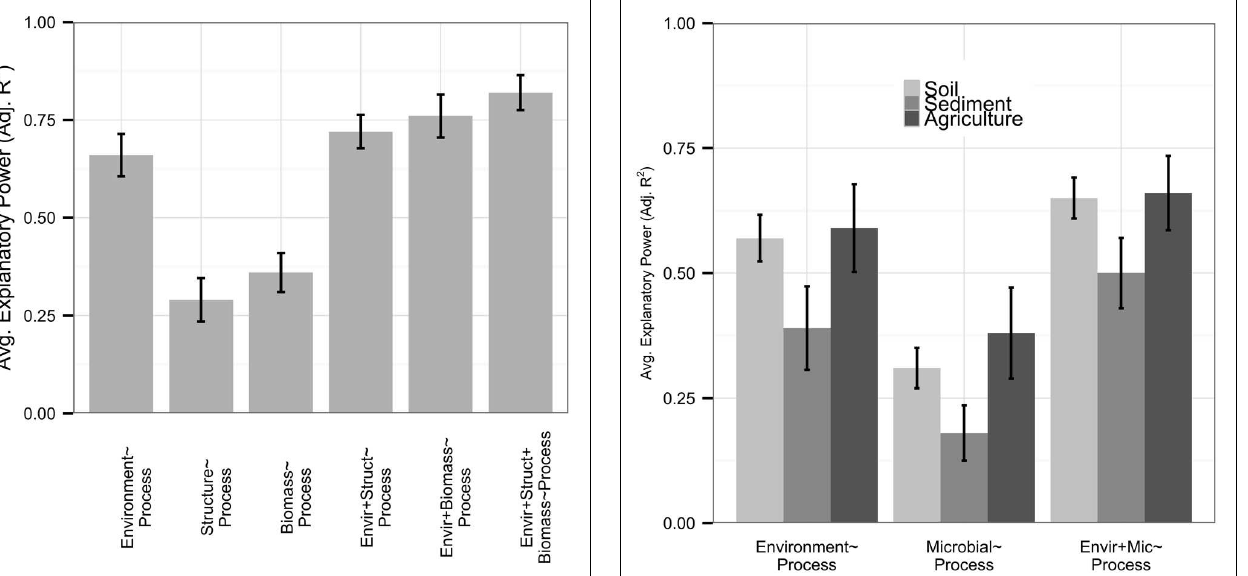
FIGURE 4 | We analyzed natural soil ( n = 47), sediment ( n = 12), and agricultural soil ( n = 12) environments separately. Bar height represents the average explanatory power of each predictor set, with error bars denoting standard errors. While predictor sets in natural soils nearly matched those within the full dataset, environmental and microbial predictor sets had lower explanatory power within sediments and higher explanatory power within agricultural soils. Microbial community diversity was less tightly coupled to the environment and provided more model improvement in sediments, with the opposite relationship in agricultural